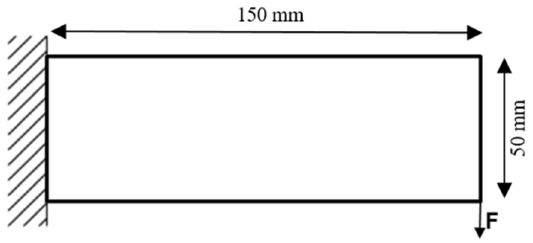
Figure 9. Design space and boundary conditions of the optimization problem.